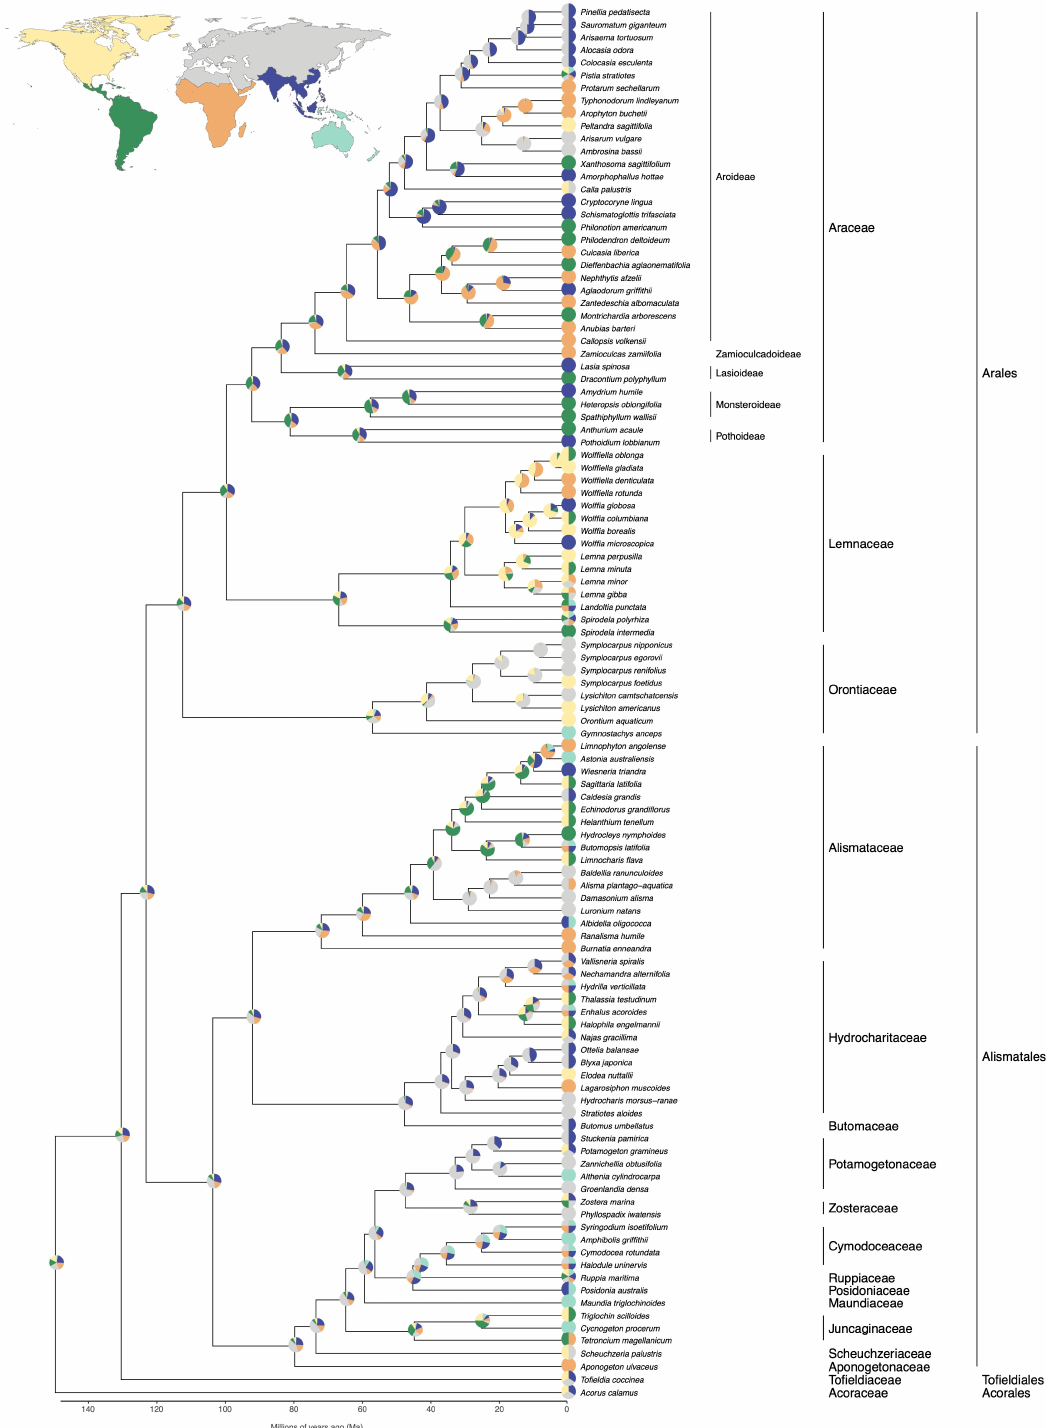
Figure 2. Phylogeny of Arales, constructed using combined DNA sequence data from five plastid regions ( matK , ndhF , rbcL , rps16 , and trnL-F ). The tree represents a maximum likelihood tree, constructed in IQ-TREE [18] using default settings. Taxa were trimmed to include only one representative species for most genera. Branch lengths were adjusted to be ultrametric using the chronopl function in the R package ape [19], and the x-axis was scaled to approximate node ages that were reported previously [20]. Ancestral biogeography was reconstructed using the ace function in the ape package, to estimate the likelihood of an ancestor occupying one or more of the biogeographical realms indicated by the colored regions in the inset map. The ancestral likelihood values are shown as pie charts at the nodes of the phylogeny.